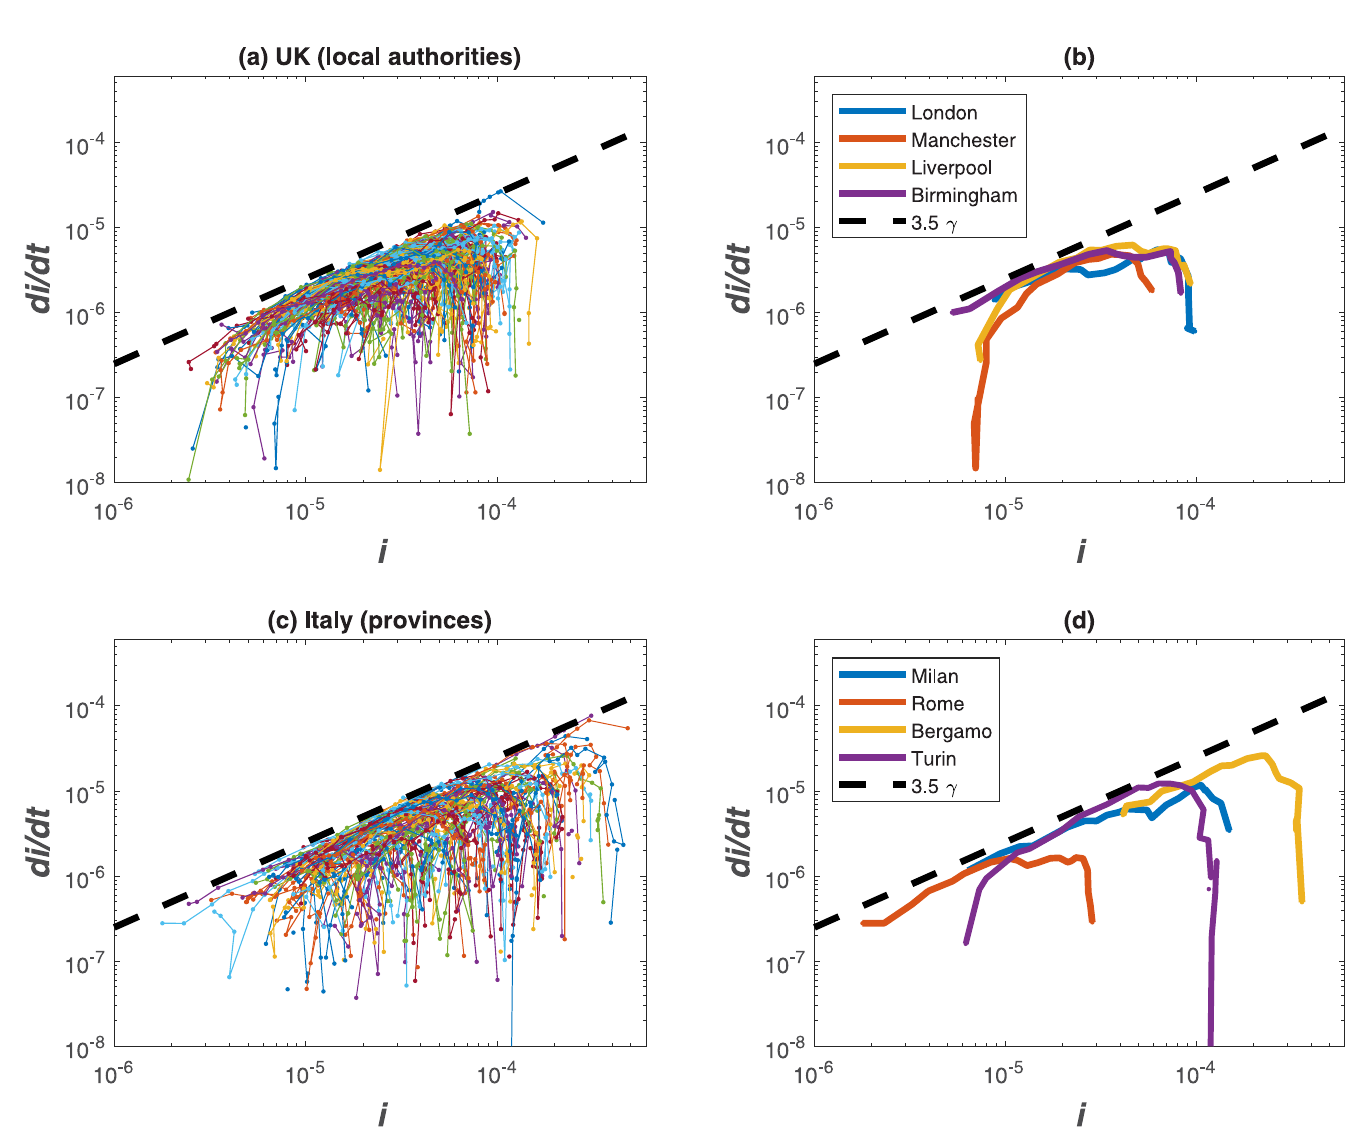
Fig 5. Same as Fig 3 but for sample UTLAs in the UK (a) and provinces in Italy (c). Selected UTLAs and provinces are shown in panels b and d, respectively.